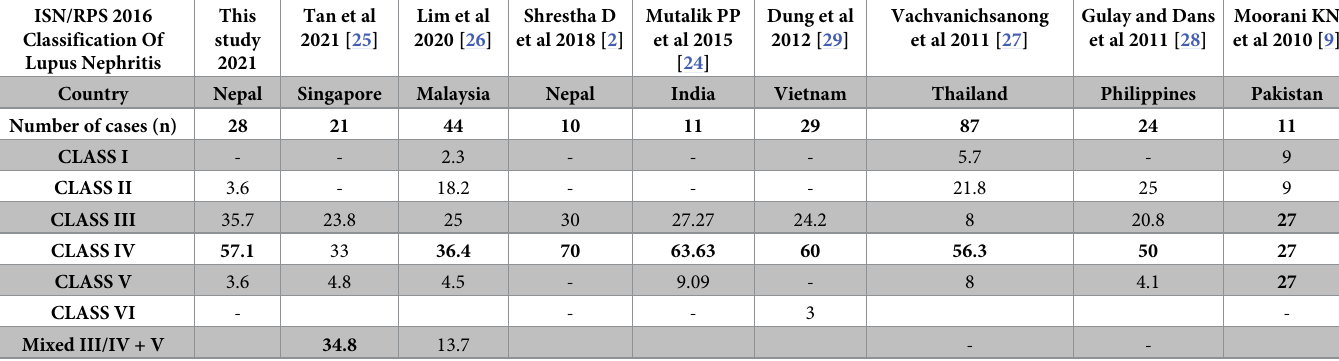
Table 6. Histopathological classification of childhood-onset lupus nephritis in Southeast Asia.